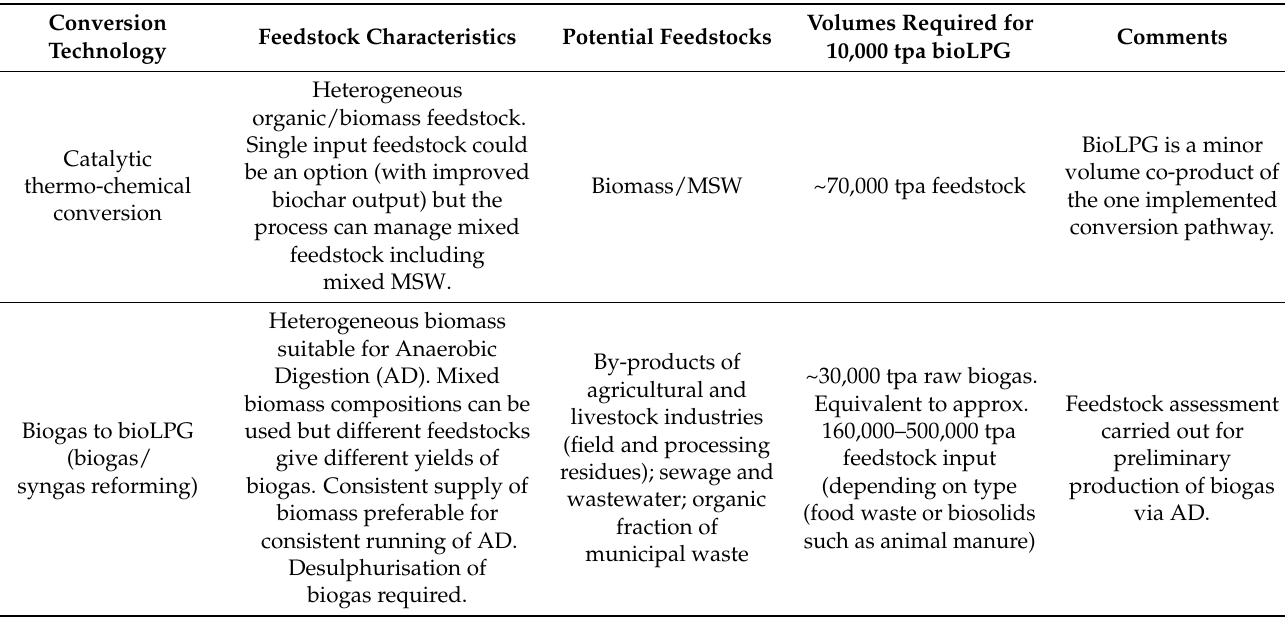
Table 2. Types of potential feedstocks in the three focus countries and quantities required for a 10,000 tpa bioLPG reference plant.